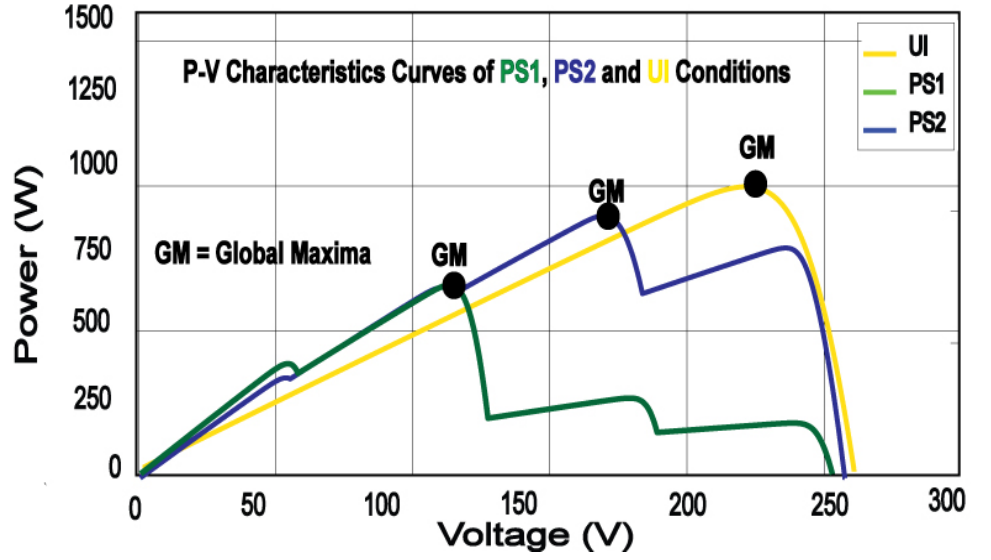
Figure 6. Complete P-V curves of PV